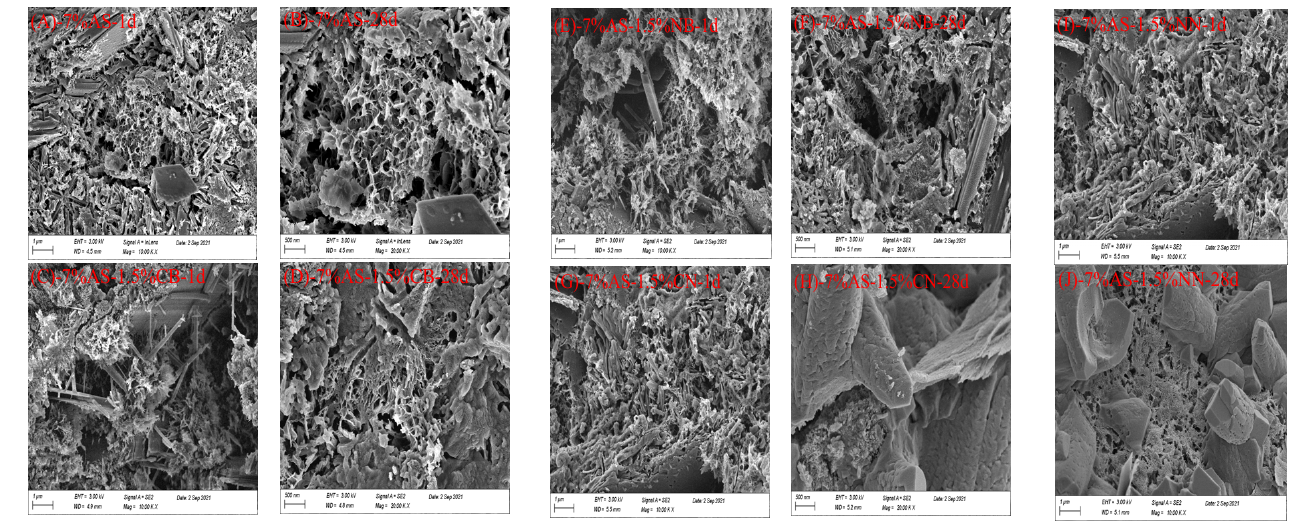
Figure 9. SEM patterns of samples: ( A , B ) hydration products of the cement paste added with 7% AS for 24 h/28 d; ( C , D ) hydration products of the cement paste added with 1.5% CB for 24 h/28 d; ( E , F ) hydration products of the cement paste added with 1.5% NB for 24 h/28 d; ( G , H ) hydration products of the cement paste added with 1.5% CN for 24 h/28 d; ( I , J ) hydration products of the cement paste added with 1.5% NN for 24 h/28 d.